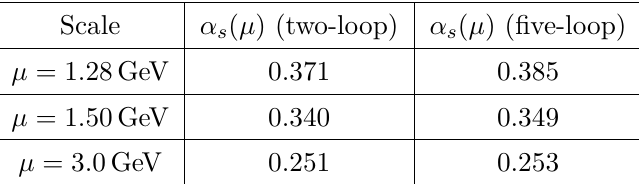
Table 20. Numerical values of α s ( µ ) evaluated with two-loop and five-loop running. For our numerical evaluations we use the values obtained with five-loop running. We used the initial value of the strong coupling constant α (5) ( m = 91 . 1876 GeV ) = 0 . 1180 . See the text for further details. s Z